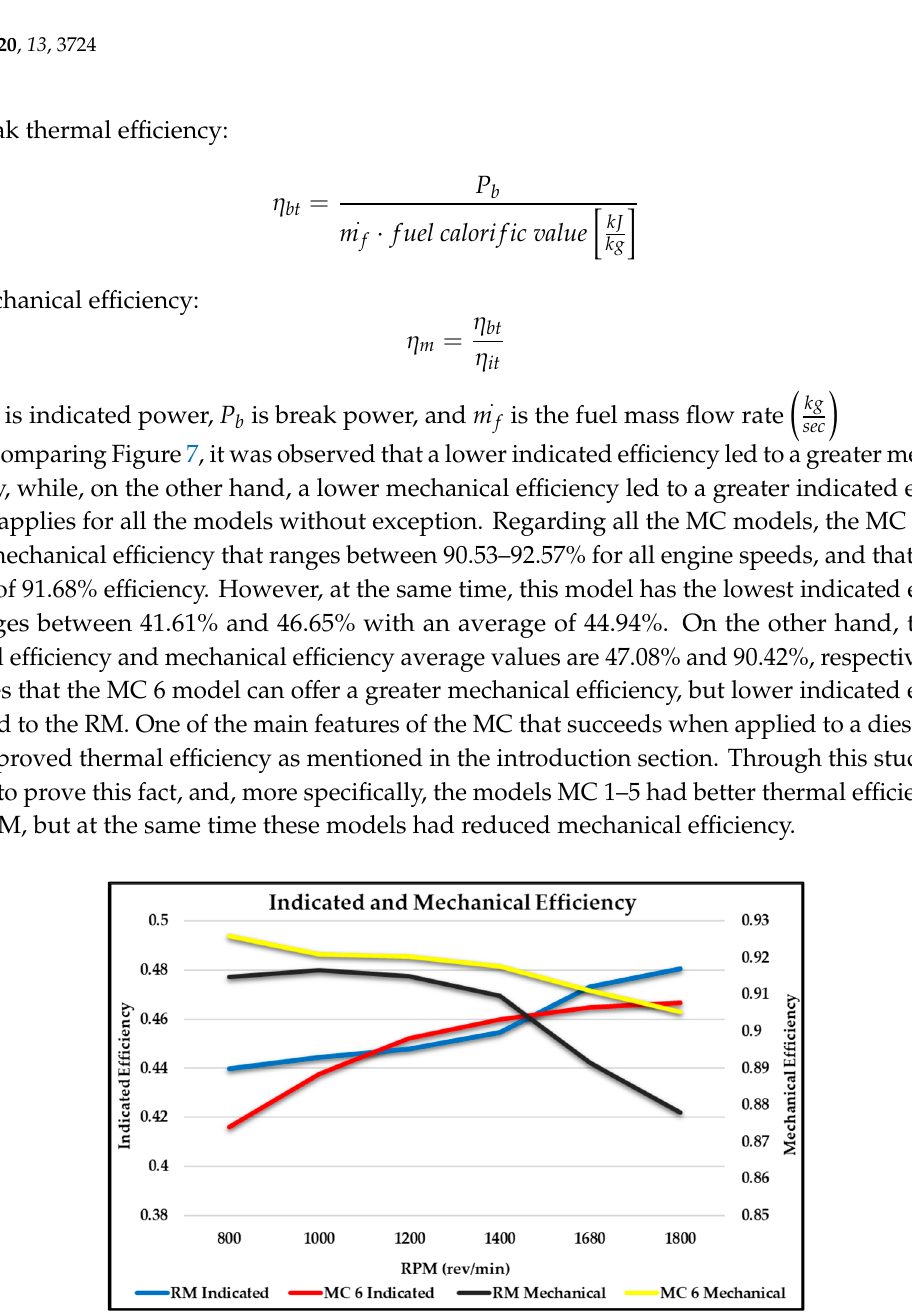
Figure 7. Indicated vs. mechanical efficiency for RM and MC 6.